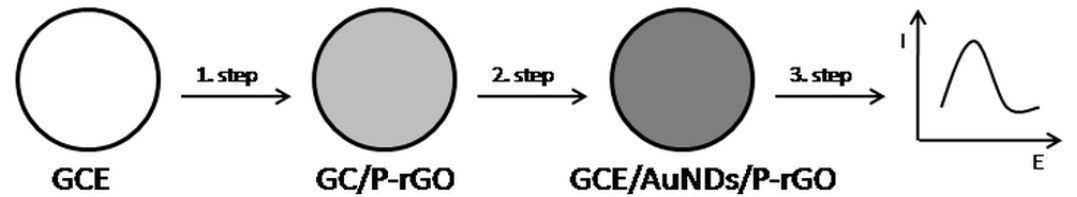
Figure 1. Schematic depiction of AuNDs/P-rGO-modified electrode preparation: 1. electrodeposition of reduced graphene oxide and Prussian blue (rGO@PB) films on GCE electrode using cyclic voltammetry with a potential range from −1.6 to +1.0 V; 2. electrodeposit Au nanodendrites at a constant potential of −0.2 V; 3. detecting Se(IV) using SWV in a potential range from −0.2 to +0.6 V.